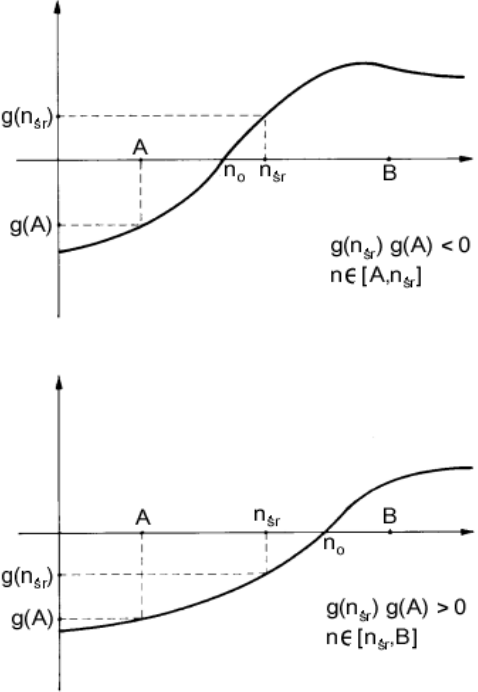
Figure 1. Determination of the root of the g ( n ) function by means of the bisection method.